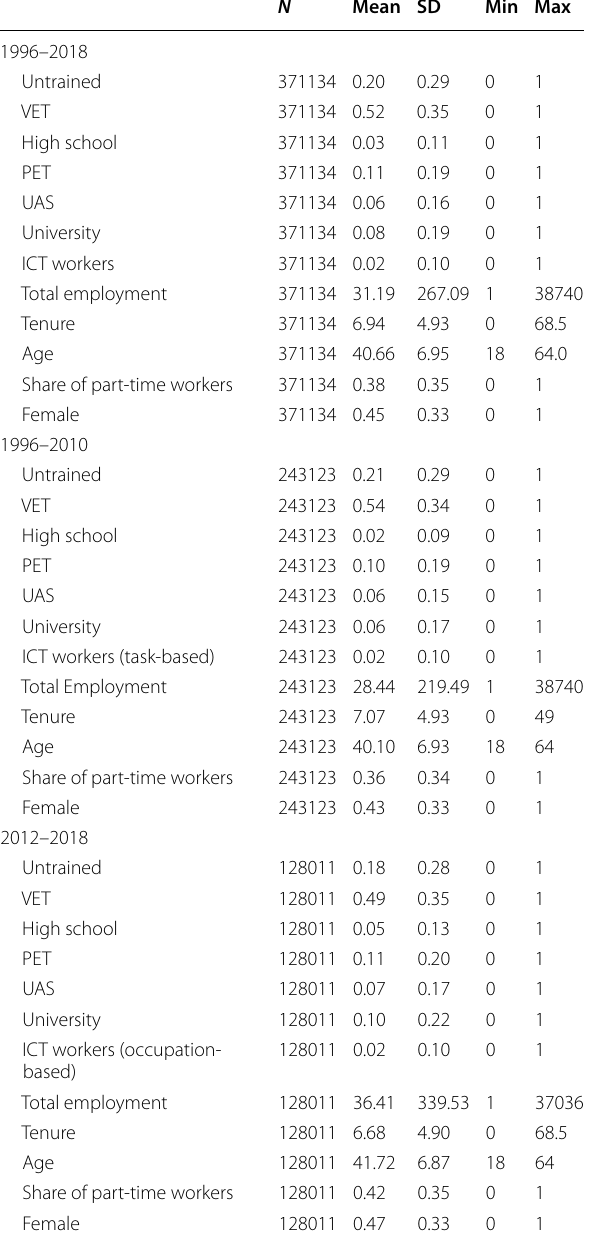
Table 2 Firm-level summary